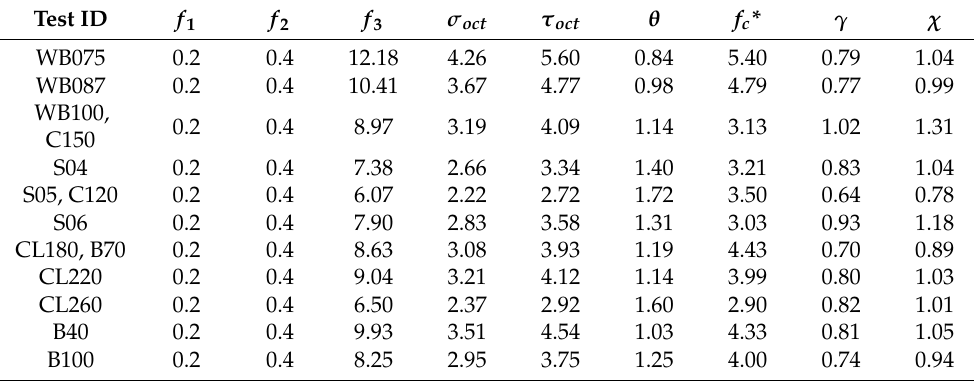
Table 7. Normal stress, shear stress and Lode’s angle in octahedral stress space under (0.2 MPa, 0.4 MPa).